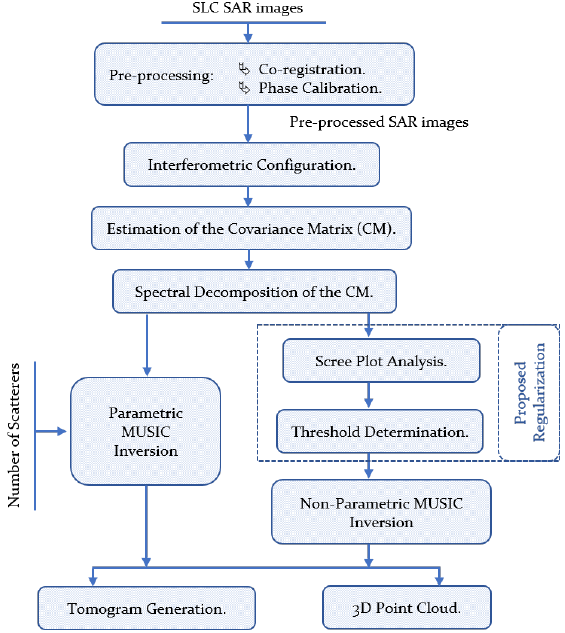
Figure 2. Block diagram of the proposed